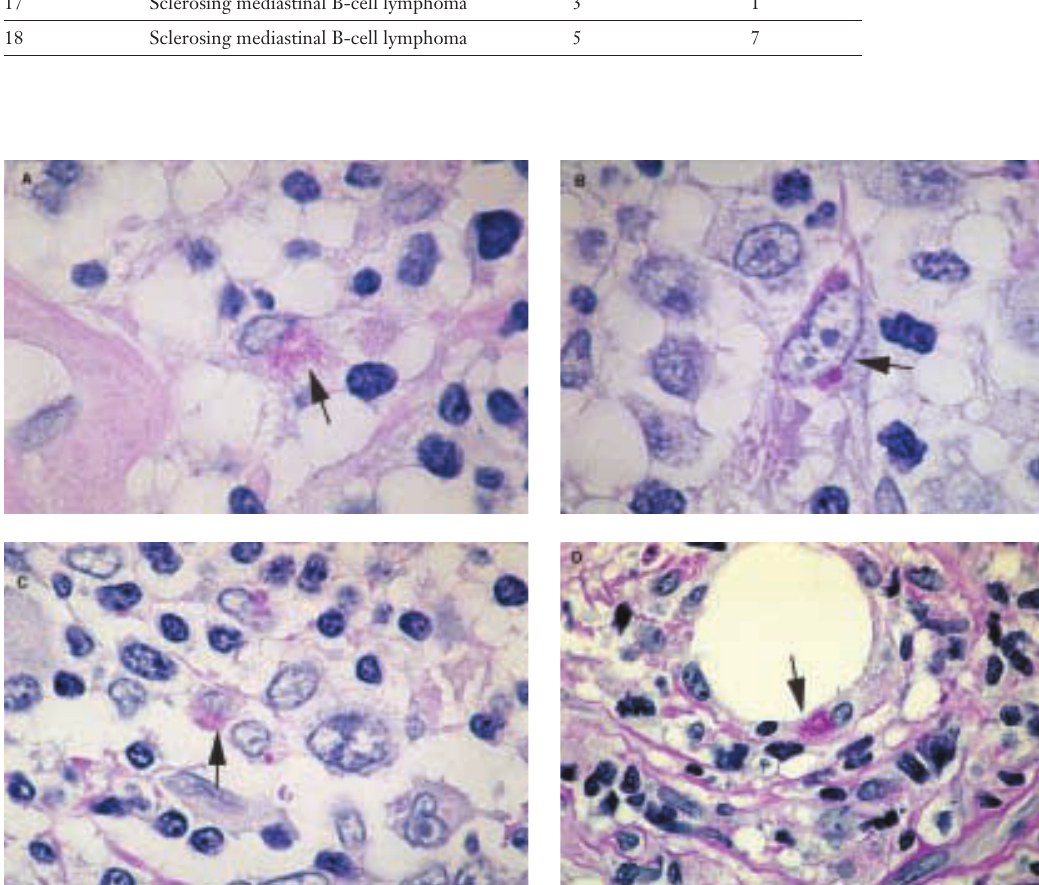
Microscopic exami- nation of PAS-stained slides at a magnifica- tion of x 1000; num- ber of cells contain- ing rods and spheres per about 2400 cells examined per